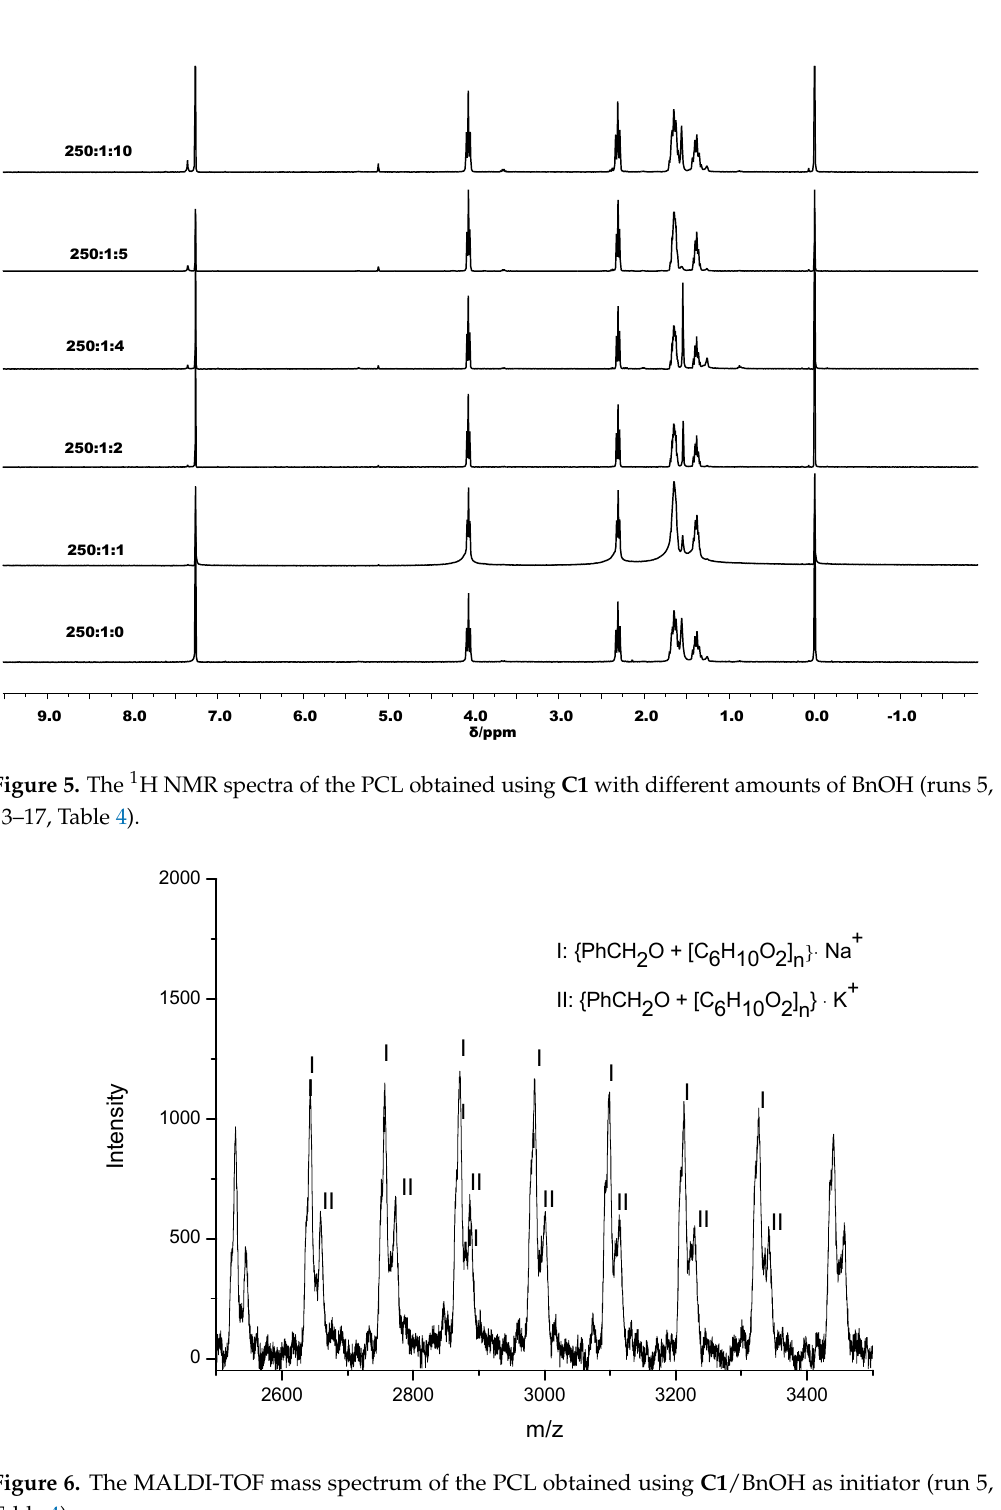
Figure 6. The MALDI-TOF mass spectrum of the PCL obtained using C1 /BnOH as initiator (run 5, Table 4).